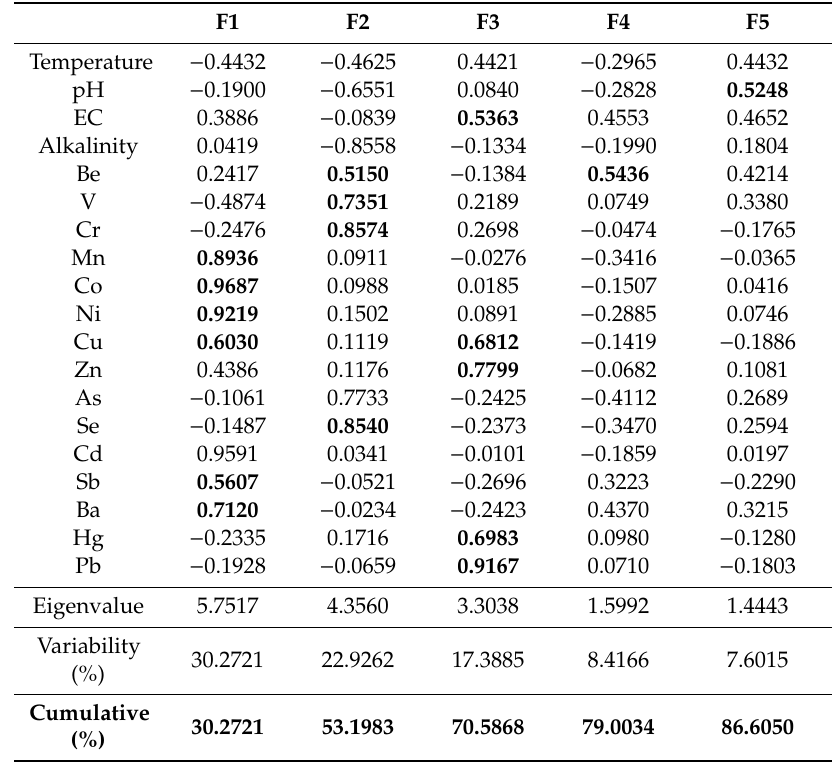
Table 6. Factor loadings of the trace metals concentrations and some physicochemical parameters.